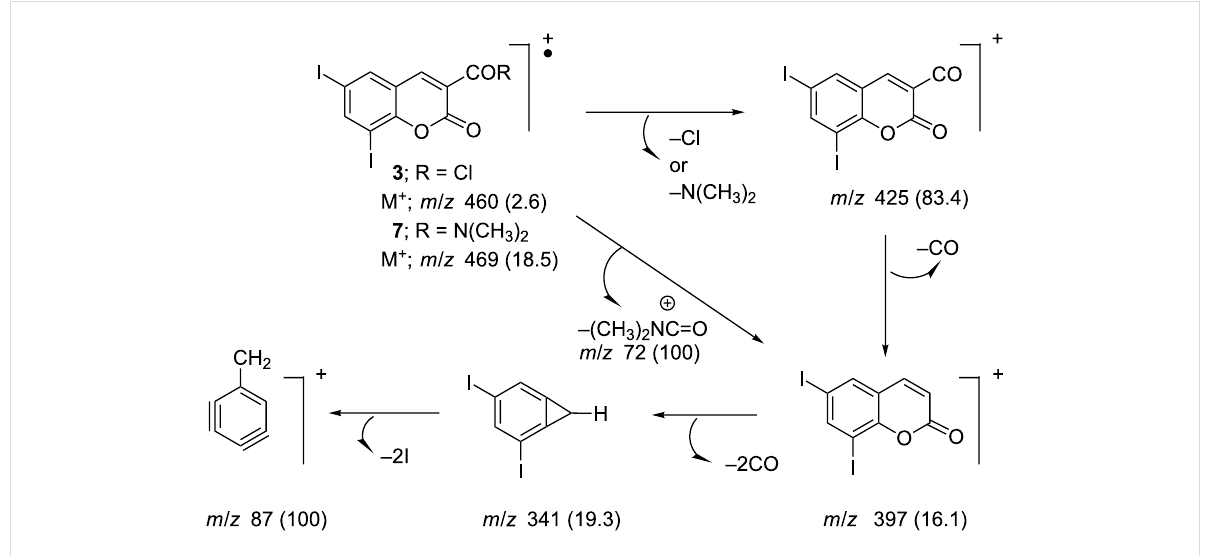
Scheme 2: Proposed fragmentation pathways for the EI ions of the substituted 6,8-diiodocoumarins 3 and 7 .